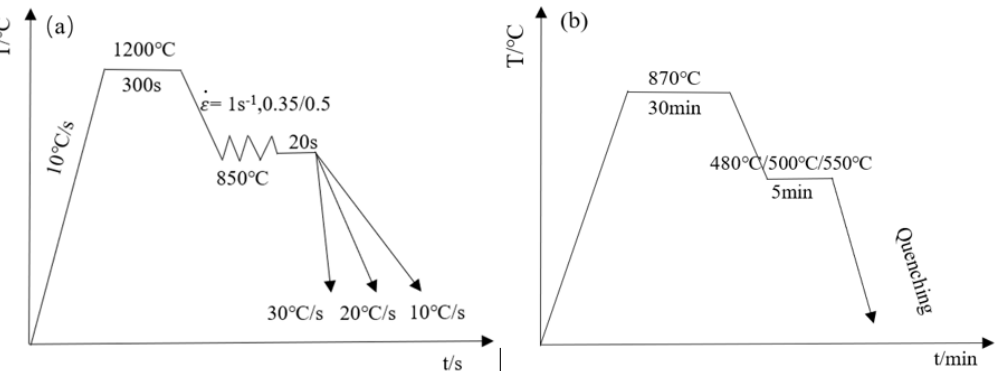
Figure 1. The schedule of the experiments for pipeline steel ( a ) thermal mechanical simulation; ( b ) isothermal quenching process.